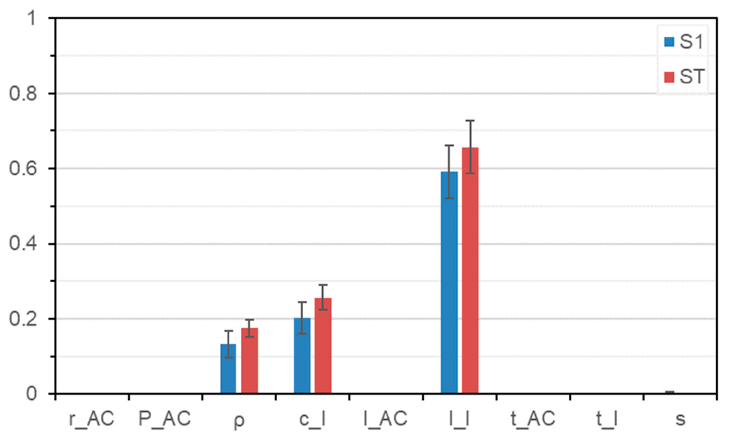
Figure 9. First-order (S 1 ) and total-order (S T ) sensitivity indexes for the expected annual impacts. Error bars represent the indexes’ con fi dence intervals (with a con fi dence level of 95%).